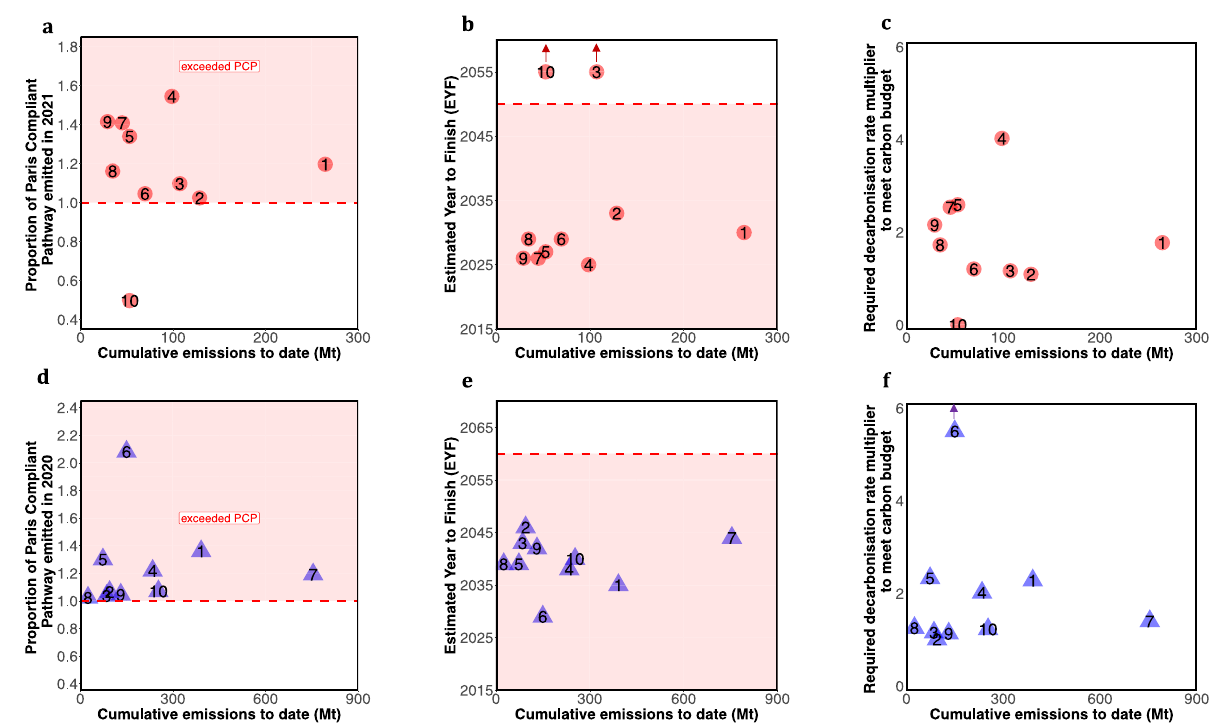
Fig. 3 Transition performance metrics for the ten largest producing electricity generators in Australia (a – c, red circles), and ten cement producers from various countries (d – f, blue triangles) for metric 1, 2a and 3. Panels a and d show Metric 1 - the proportion of the Paris-Compliant Pathway (PCP) (in absolute emissions, PCP emissions ) actually emitted in 2021 since the base year 2014, the shading above a value of one indicates the company has exceeded its PCP. Panels b and e show Metric 2A - the Estimated Year to Finish the carbon budget if carbon intensity is decarbonised according to the “ maximum action ” scenario (panel b ) or geometric carbon intensity growth 2014 – 2020 (panel e ), the shading below 2050 for Electric Utilities (panel b ) and 2060 for Cement (panel e ) indicates the company is expected to fi nish its entire carbon budget prior to the timeframe given by the underlying decarbonisation pathway (IEA B2DS). Panels c and f show Metric 3 - the multiplier on decarbonisation rates required (compared to if it had followed its PCP (in carbon intensity, PCP intensity ) since 2014) to be Paris-Compliant. Additional metrics are shown in Supplementary Data Fig. 4. Panels a – c : 1 = AGL, 2 = Energy Australia, 3 = Origin, 4 = Stanwell, 5 = CS Energy, 6 = Alinta, 7 = Delta, 8 = Millmerran, 9 = Callide and 10 = Engie. Panels d – f , 1 = Heidelberg cement, 2 = ACC, 3 = Ambuja cement, 4 = Ultratech cement, 5 = Shree cement, 6 = CRH (LON), 7 = Holcim, 8 = Asia Cement, 9 = Siam Cement, 10 = Cemex CPO.